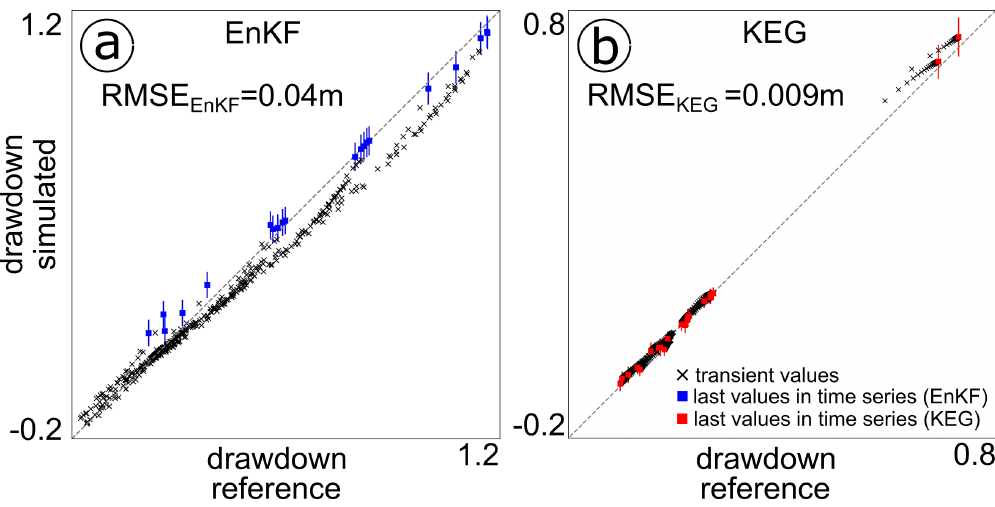
Figure 9. Calibration plot for the ensemble predictions of drawdown from pumping test A after assimilation of all concentration data. ( a ): ensemble mean of transient drawdown simulated with the EnKF. ( b ): ensemble mean of transient drawdown simulated with the